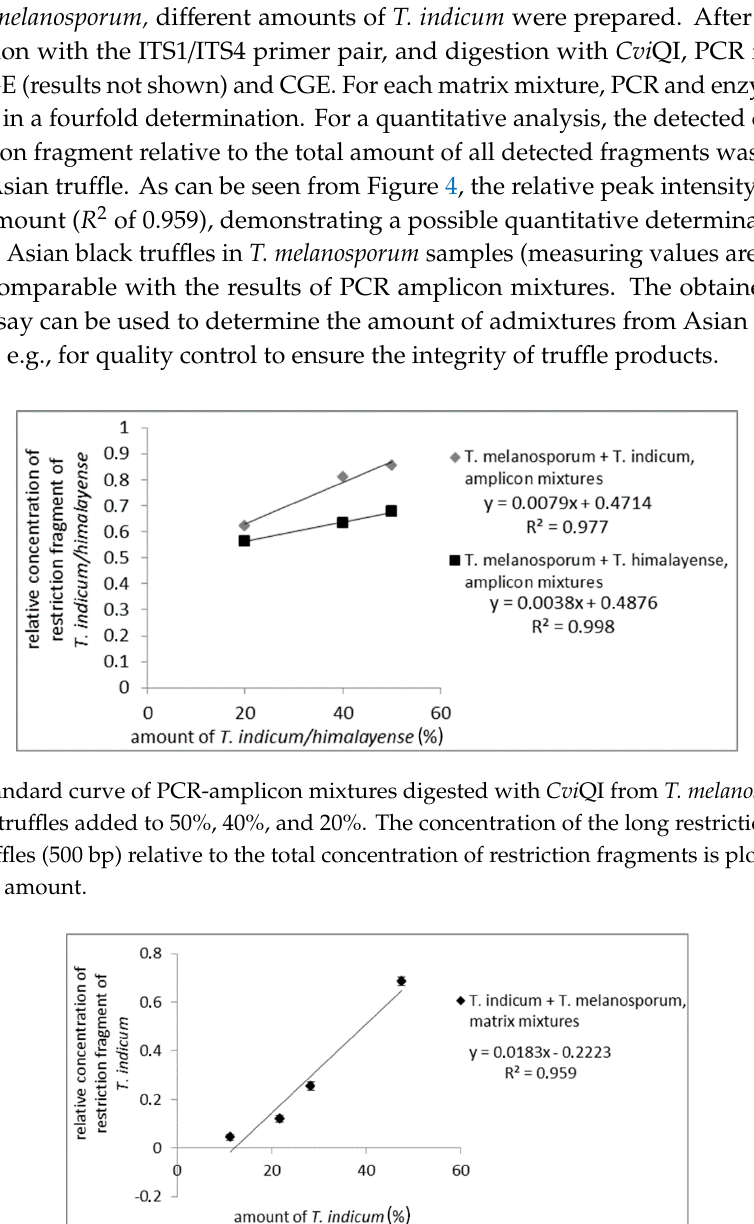
Figure 4. Standard curve of matrix mixtures from fruiting bodies of T. melanosporum with Asian black tru ffl es with 11.2%, 21.7%, 28.3%, 47.5% Asian tru ffl e. The concentration of the long restriction fragment (ITS1 / ITS4 PCR amplicon digested with Cvi QI) of Asian tru ffl es (500 bp) relative to the total concentration of restriction fragments is plotted against Asian tru ffl e